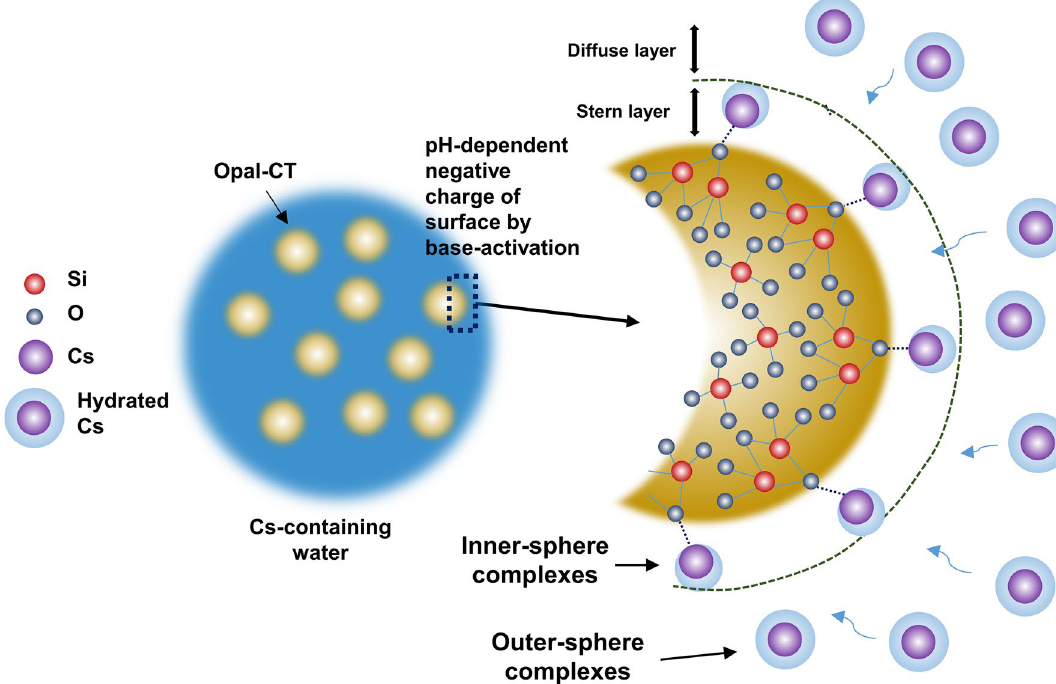
Figure 8. Schematic of the Cs adsorption mechanisms and dynamic behavior of the base-activated opaline mudstone (Si − O functional groups and hydrated Cs images modified from Khraisheh et al. 32 and Lee et al. 13